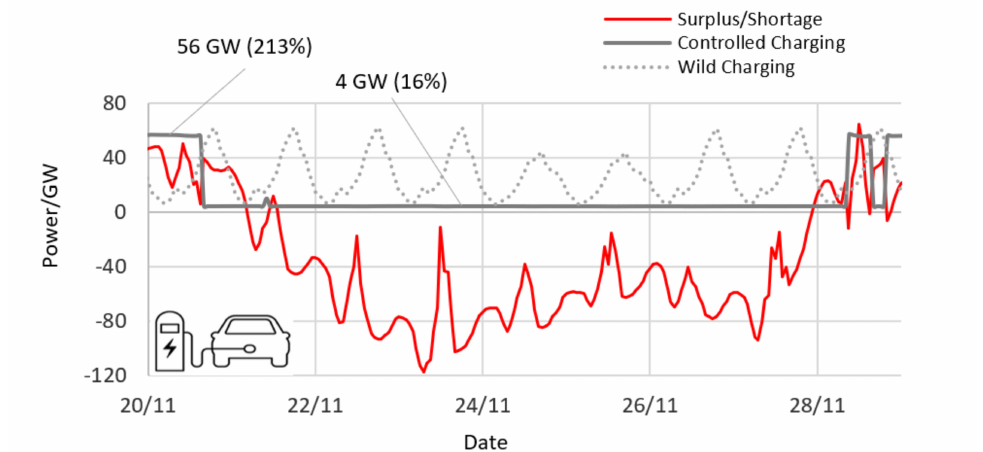
Figure 6. Controlled charging (full green) with either 16% or 213%of the average